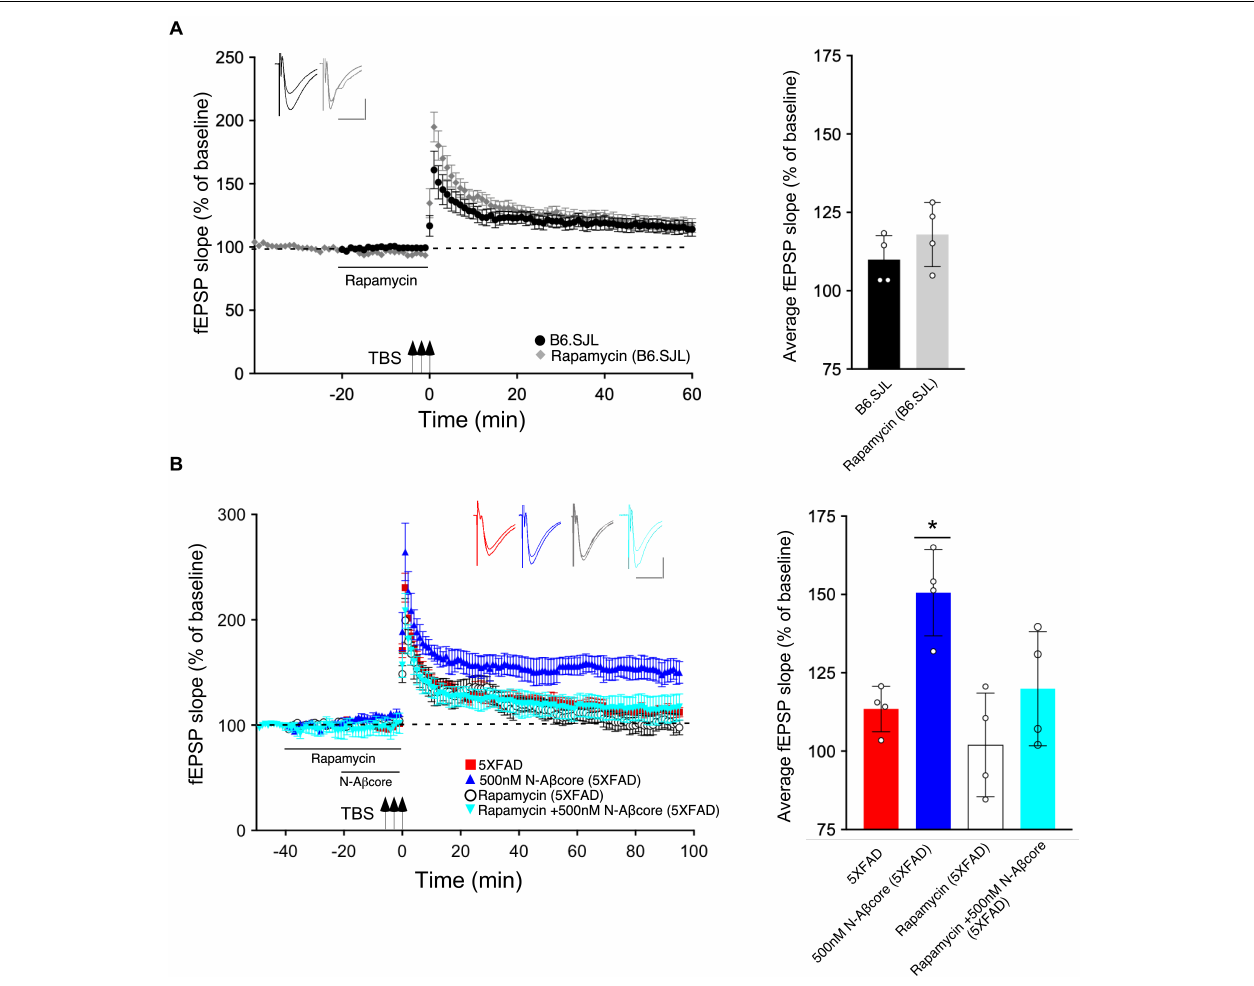
FIGURE 4 | N-A β core protection of A β -induced synaptic dysfunction involves mTOR downstream in the PI3 kinase pathway. (A) Left, Lack of effect of acute pretreatment of 500 nM rapamycin (gray) on TBS-induced LTP for B6.SJL slices as compared to LTP induced in aCSF-treated B6.SJL control slices (black) from 4–5 month-old mice. Right, Comparison of average fEPSP slope values for 50–60 min post-TBS for B6.SJL slices incubated in 500 nM rapamycin to aCSF-treated B6.SJL control slices ( t ( 6 ) = 0.26, p = 0.8023; two-tailed unpaired Student’s t -test). (B) Left, TBS-induced LTP for 5xFAD slices with aCSF (red), 500 nM rapamycin (white circle), 500 nM N-A β core (cyan) or 500 nM N-A β core plus 500 nM rapamycin (blue). Right, Rescue of LTP deficit following 20-min 500 nM N-A β core treatment in 5xFAD slices (* p = 0.0217, Bonferroni post hoc test after one-way ANOVA, F ( 3 , 12 ) ) was abolished with 500 nM rapamycin pretreatment (40 min) (ns, Bonferroni: rapamycin + N-A β core in 5xFAD vs. 5xFAD alone). There was no effect of acute pretreatment of rapamycin on LTP in 5xFAD slices (ns, Bonferroni: rapamycin in 5xFAD vs. 5xFAD alone). Arrows indicate timing of TBS in (A) and (B) . All recording data (A,B ) are means ± SEM. Averaged data for 50–60 min post-tetanus are means ± SD. N = 4 for each condition (1 slice/mouse). Color-coded insets show examples of fEPSPs (baseline vs. LTP). Calibration bars for insets: horizontal, 10 ms; vertical, 0.4